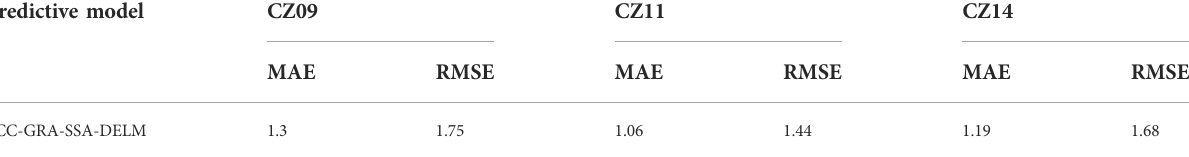
TABLE 3 Error analysis table of 3 monitoring points. Predictive